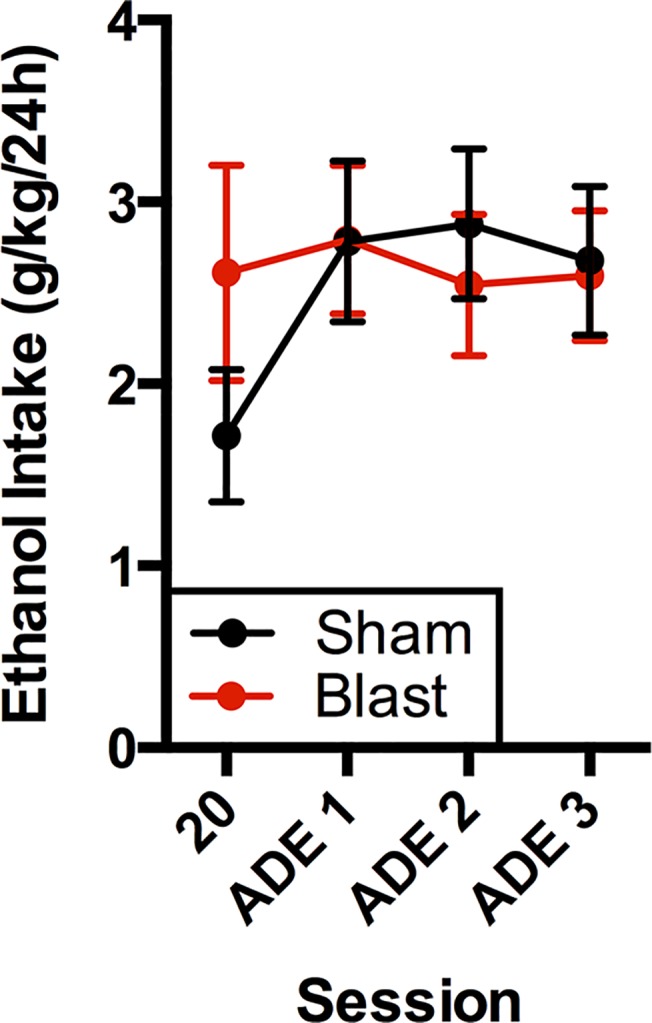
Ethanol intake after deprivation periods.Rats were tested in two-bottle choice (20% ethanol/water) sessions that started two weeks after intermittent access two-bottle choice sessions. Each session was 24 hours in length and had a two-week alcohol deprivation period prior to it. Session 20 (the final 24 hour session during the intermittent access phase) and three ADE sessions are shown for comparison. Bars represent mean ± SEM.